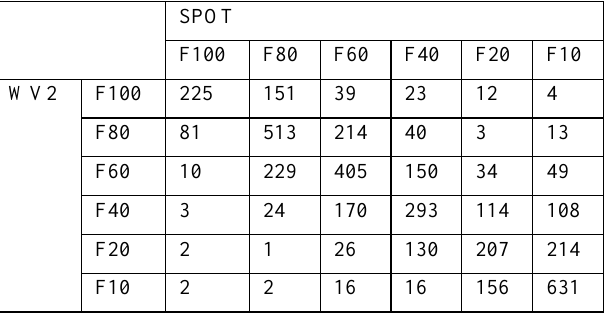
Table 3. Confusion matrix of classification with the